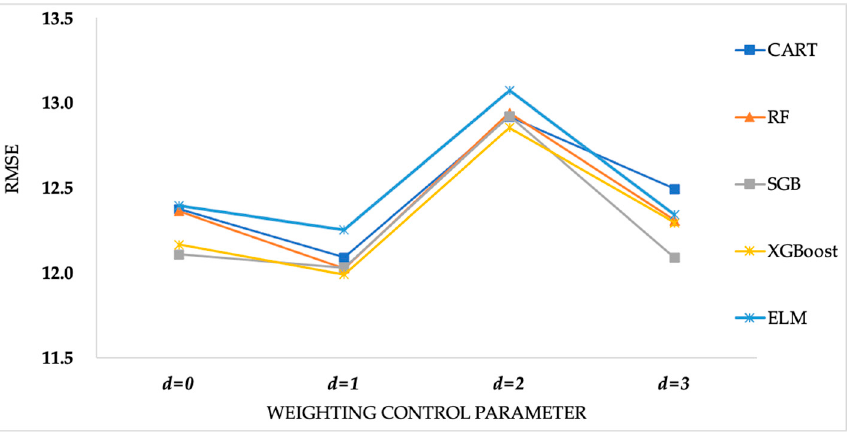
Figure 9. Prediction performance of prediction models with weighting control parameter ( d ) from 0 to 3 under game-lag ( l ) = 6.